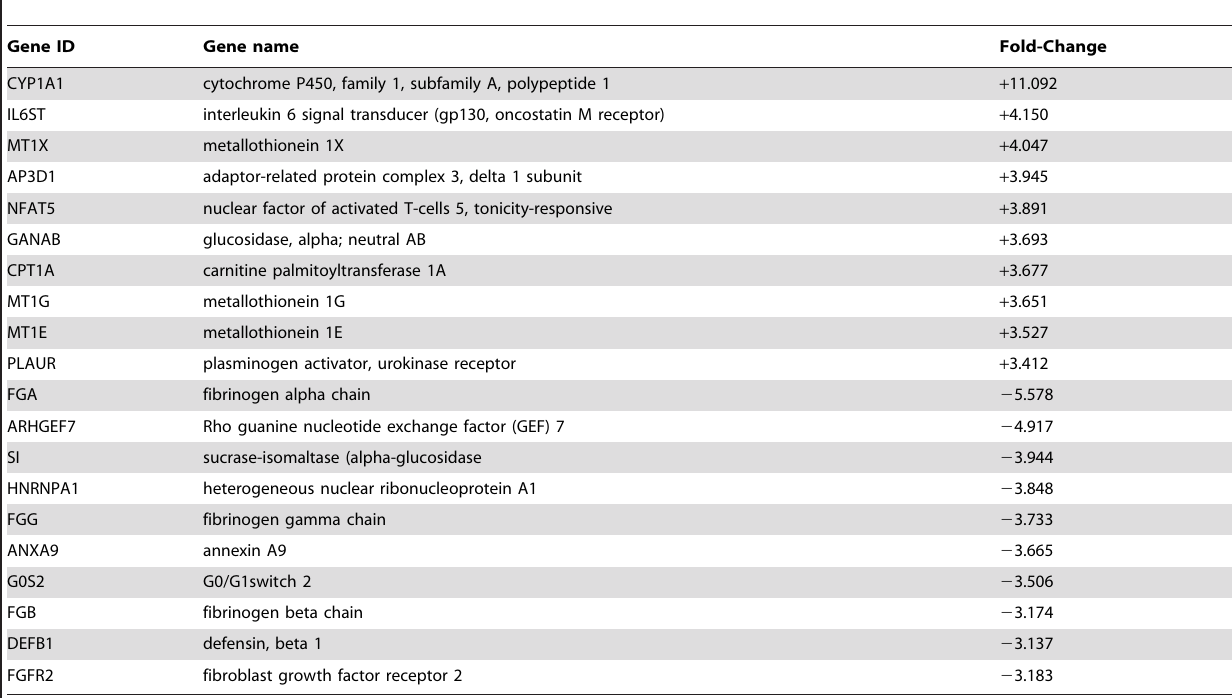
Table 4. The top ten genes modulated by the treatment with rosiglitazone +